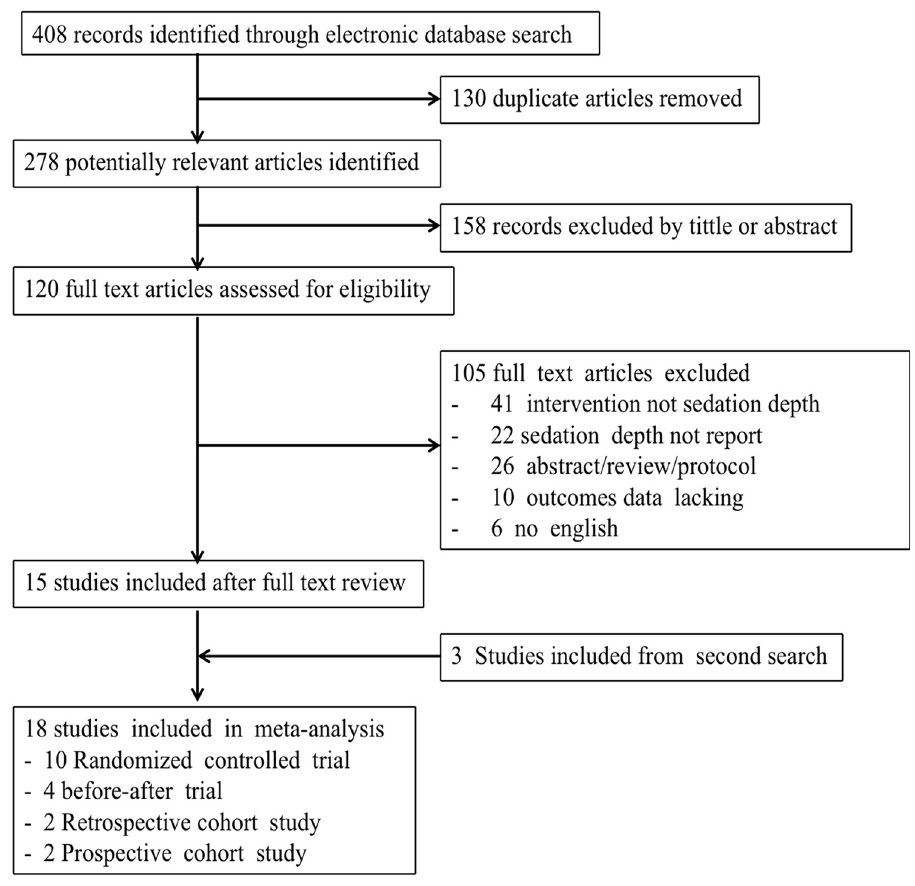
Fig 1. Flowchart of the recruited